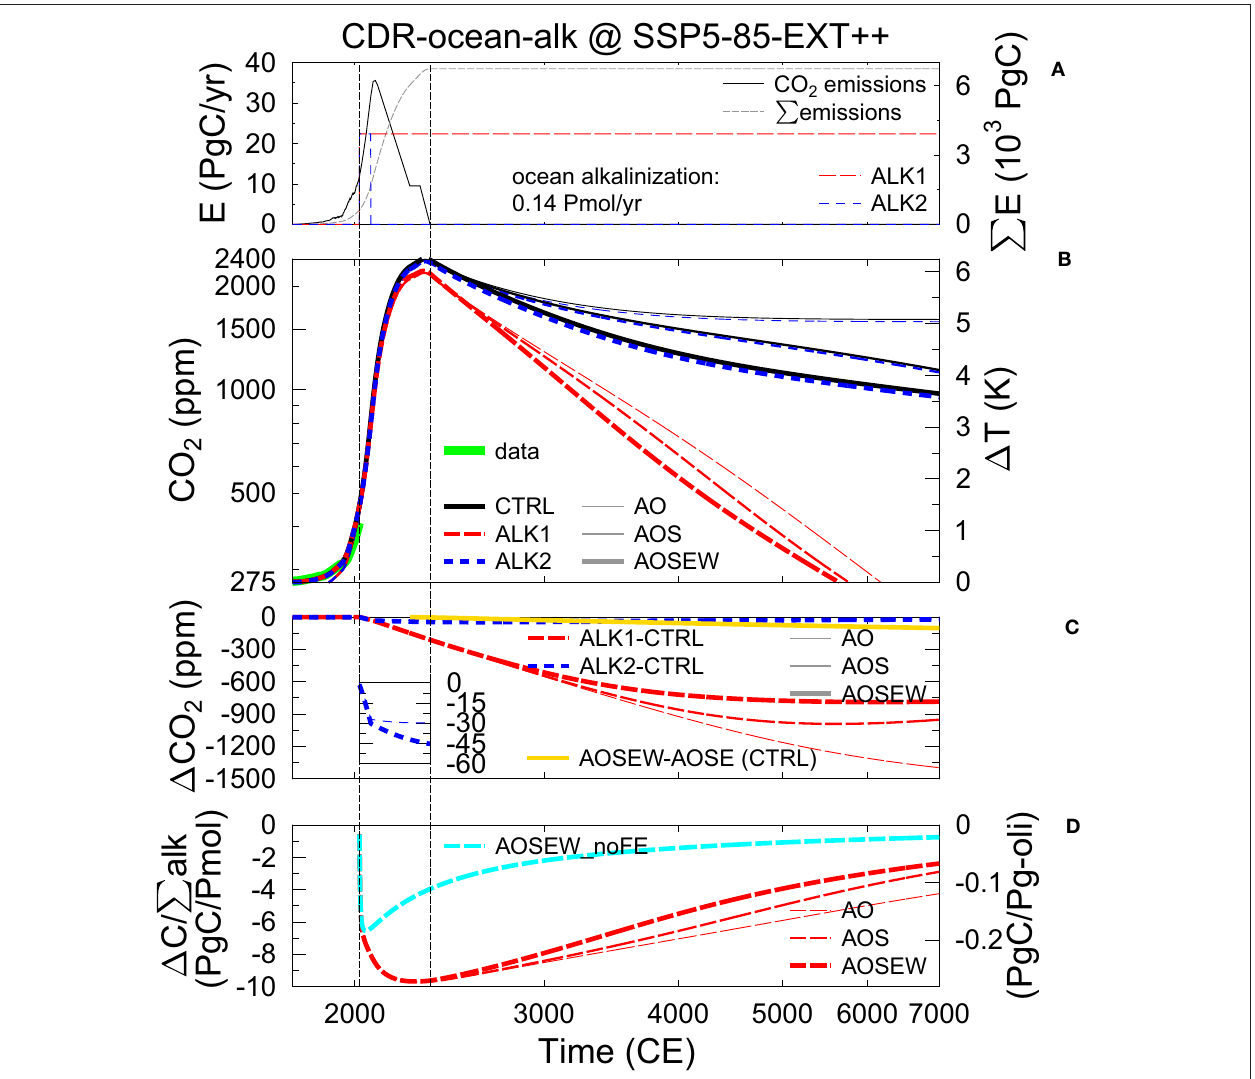
FIGURE 2 | (A) CO 2 emissions of the control run SSP5-85-EXT++ (annual and cumulative emissions E and left and right y-axis, respectively). Timing of ocean alkalinization of 0.14 Pmol/yr in scenarios ALK1 and ALK2 sketched in red and blues lines, respectively (no y-axis). (B) Resulting atmospheric CO 2 (left y-axis on log scale) and global temperature change 1 T with respect to pre-industrial (right y-axis) including a spline through compiled CO 2 data (Köhler et al., 2017), extending years 2016–2019 CE with online available data from NOAA. (C) Anomaly in atmospheric CO 2 with respect to a CTRL with alkalinization in scenarios ALK1 and ALK2. Zoom-in shows otherwise hardly detectable changes in atmospheric CO 2 due to ALK2 (results for AO and AOS are not distinguishable). Additionally the contribution of the CO 2 -dependent weathering in the CTRL runs is shown. (D) Efficiency of ocean alkalinization (ratio of C extracted from the atmosphere over accumulated alkalinization) in ALK1. On the right y-axis, the efficiency is transferred in PgC/Pg of olivine assuming a molar mass of 140 g/mol corresponding to the iron-free version of olivine called forsterite (Mg 2 SiO 4 ). Additionally, efficiency is shown for a scenario without future emissions (AOSEW_noFE). In (B,C,D) , results from three different setups are plotted: atmosphere-ocean only (AO), atmosphere-ocean including a sedimentary response function (AOS), or atmosphere-ocean in a solid Earth setup including